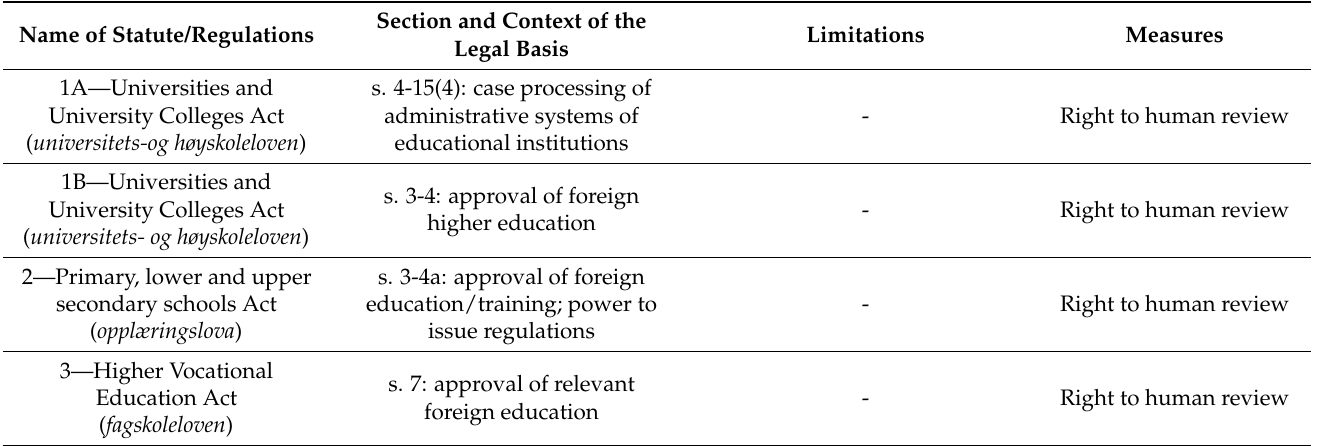
Table 1. Substantive amendments to primary and secondary legislation passed by